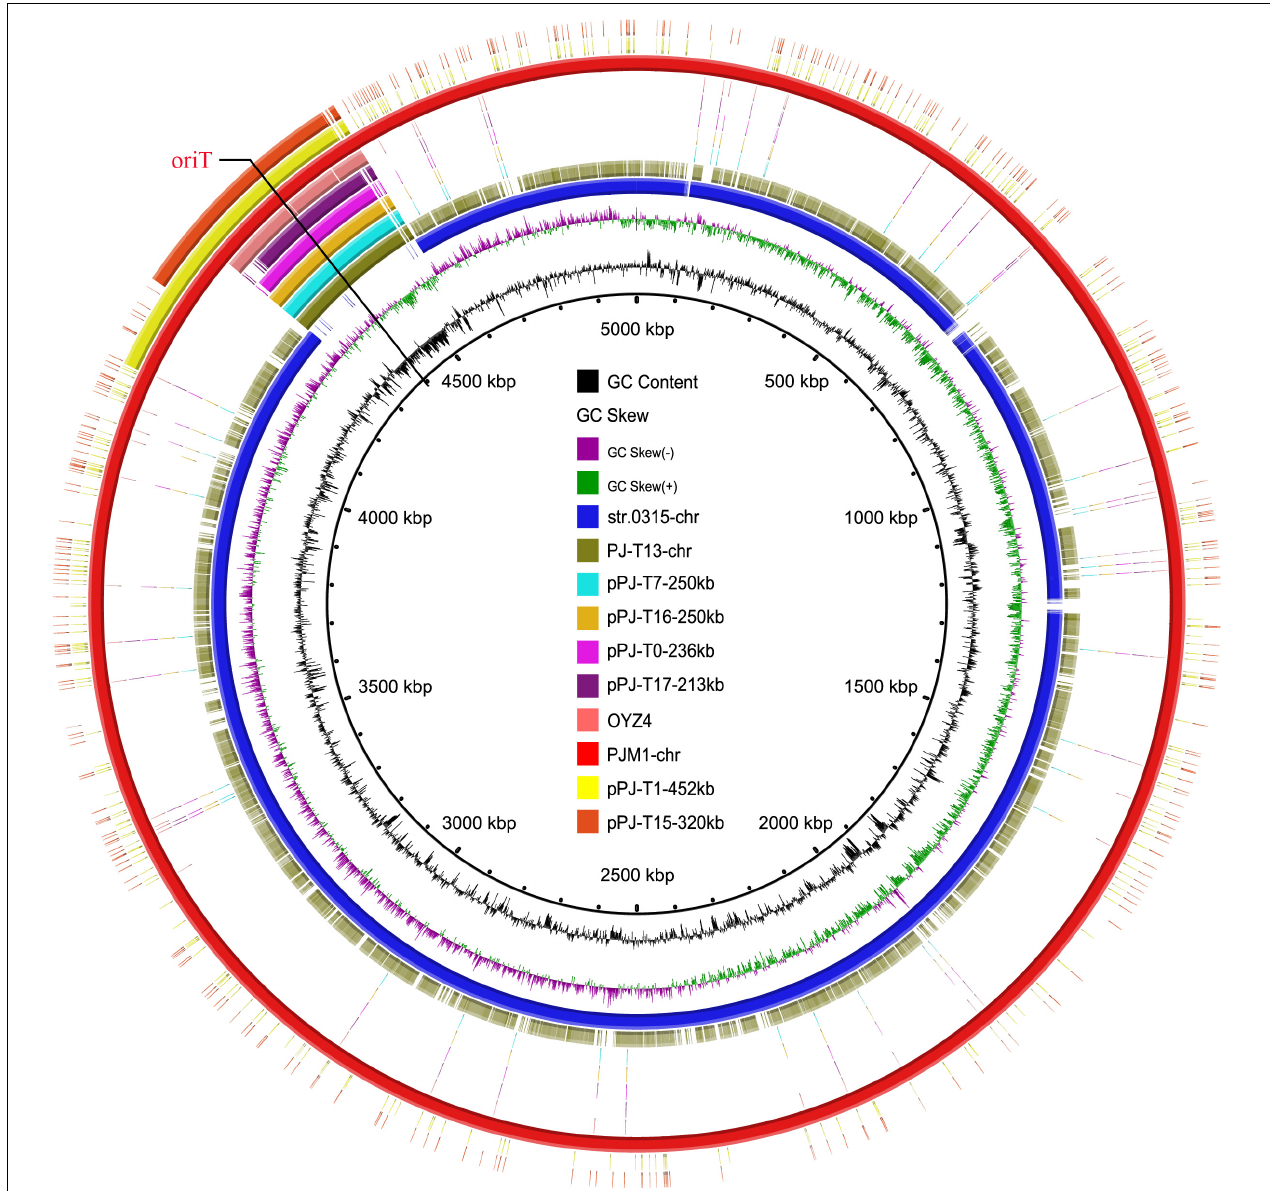
FIGURE 1 | Circular alignment of chromosomes PJM1-chr, str.0315-chr, and PJ-T13-chr and plasmids pPJ-T17-213kb, pPJ-T0-236kb, pPJ-T16-250kb, pPJ-T7-250kb, pOYZ4, pPJ-T1-452kb, and pPJ-T15-320kb. The red circle denotes chromosome PJM1-chr as a reference. Bright blue and olive-green circles represent str.0315-chr (NZ_CP019198) and PJ-T13-chr, respectively; aqua, sallow, violet, deep purple, coral red, yellow, and orange-red circles depict the plasmids pPJ-T7-250kb, pPJ-T16-250kb, pPJ-T0-236kb, pPJ-T17-213kb, pOYZ4, pPJ-T1-452kb, and pPJ-T15-320kb,